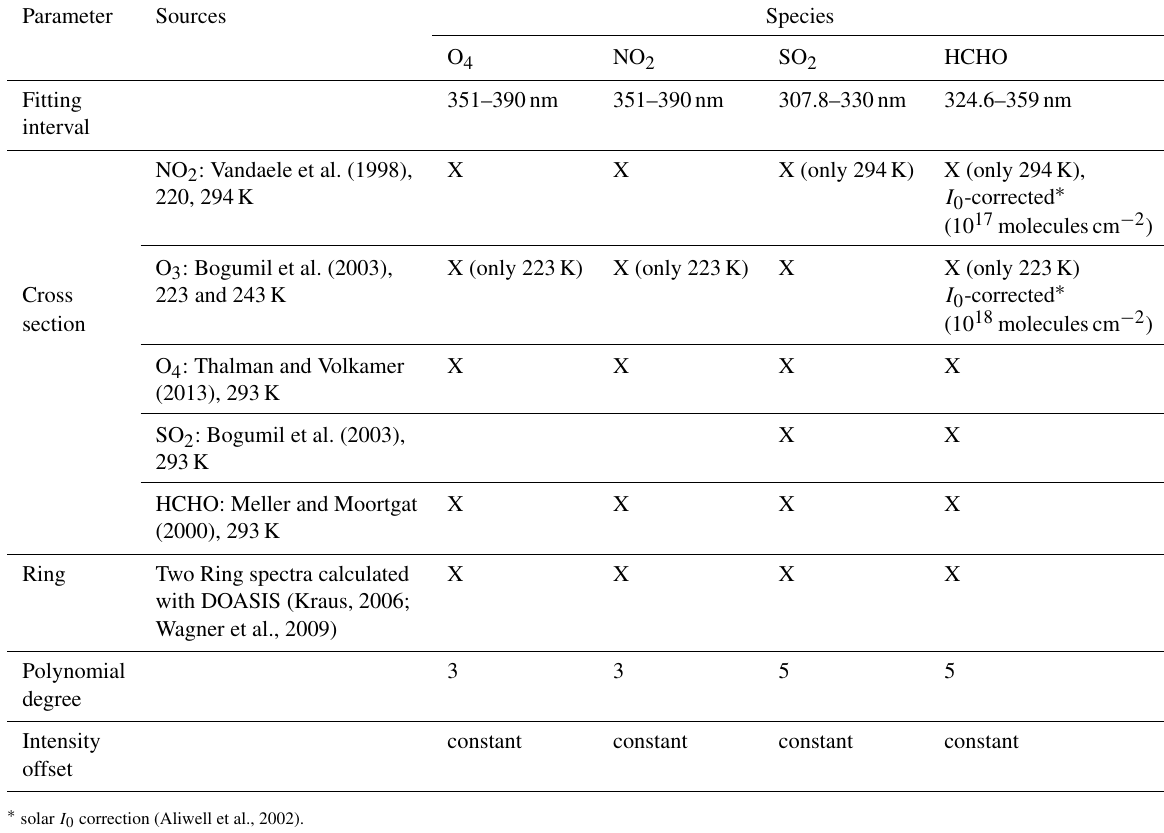
Table 1. Settings used for the O 4 , NO 2 , SO 2 and HCHO DOAS analyses.